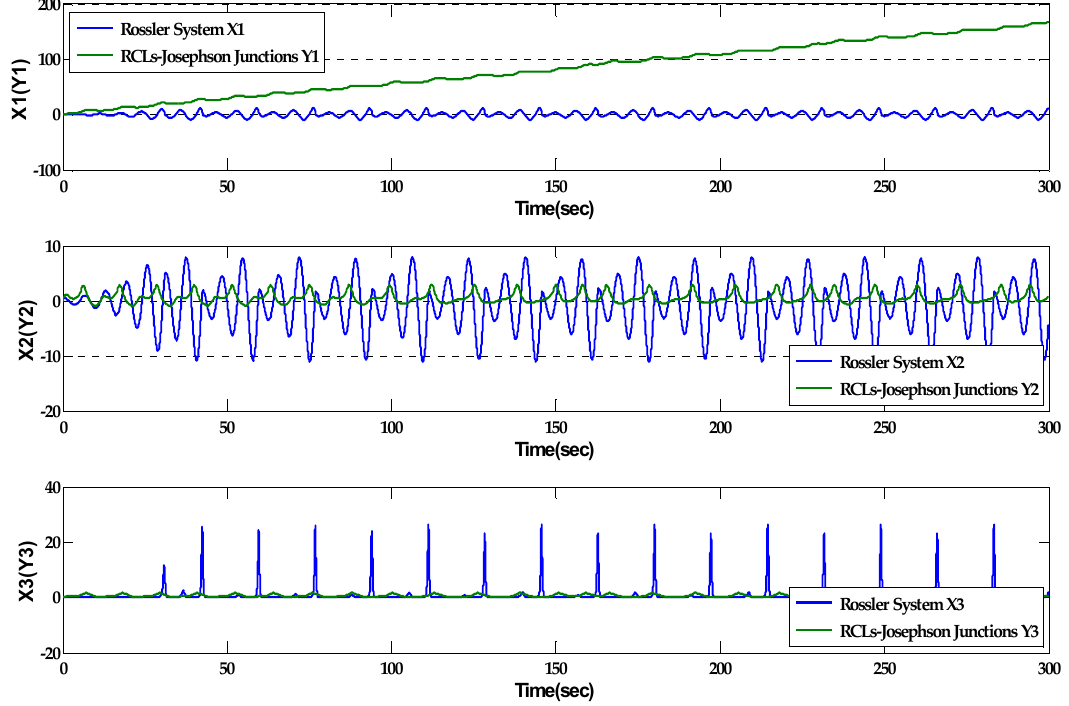
Figure 1. The time response of the Rossler system and the resistive–capacitive–inductance shunted Josephson Junction (RCLs-JJ) system.